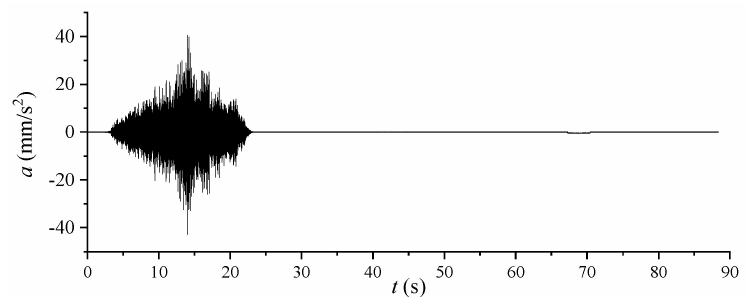
Figure 9. Mid-span acceleration at 20 km/h.